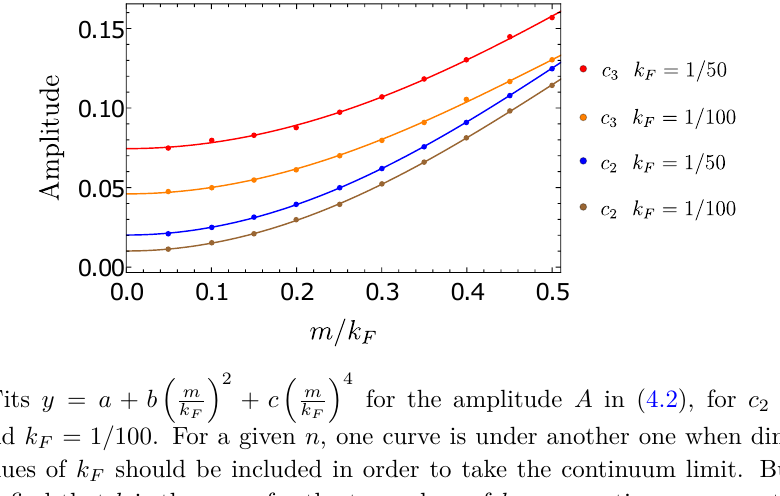
(cid:16) (cid:17) 2 (cid:16) (cid:17) 4 m m Figure 6 . Fits y = a + b + c for the amplitude A in (4.2), for c 2 and c 3 , with k F k F k F = 1 / 50 and k F = 1 / 100 . For a given n , one curve is under another one when diminishing k F ; additional values of k F should be included in order to take the continuum limit. But already at this order, we find that b is the same for the two values of k F , suggesting we are not far from the continuum limit. We obtain b = 0 . 49 for n = 2 and b = 0 . 38 for n = 3